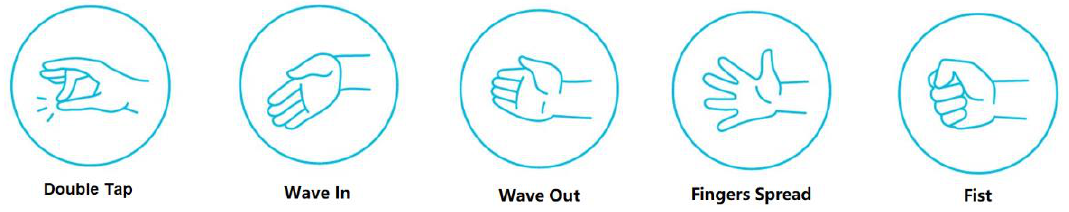
Figure 2. Five Figure 2. Five gestures.